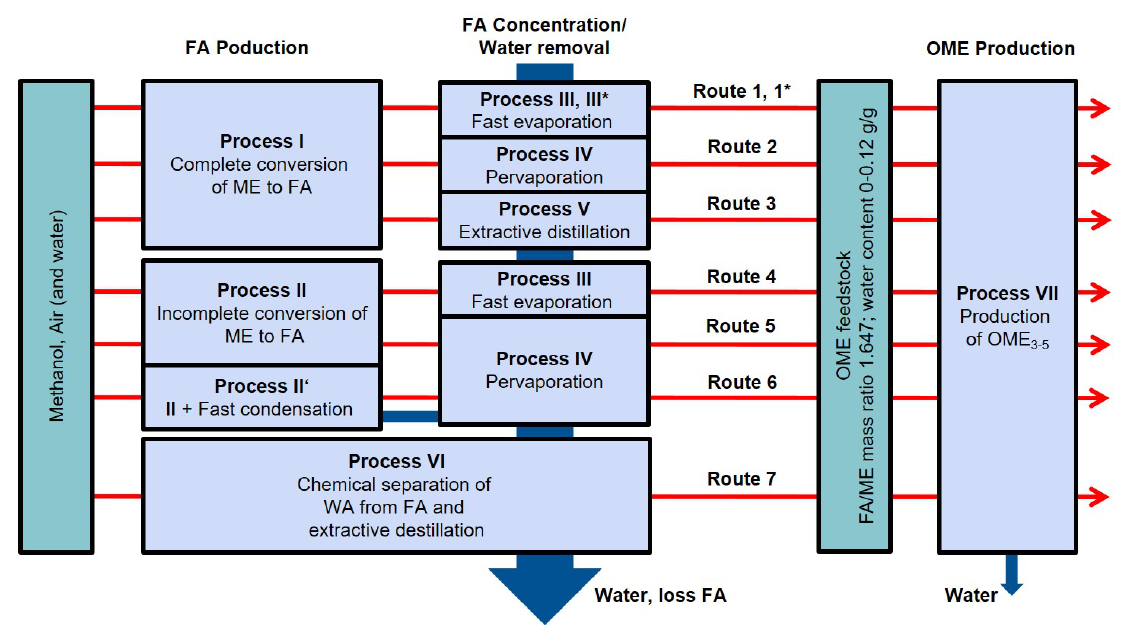
Figure 1. Overview of all considered processes in this work. Processes are numbered as